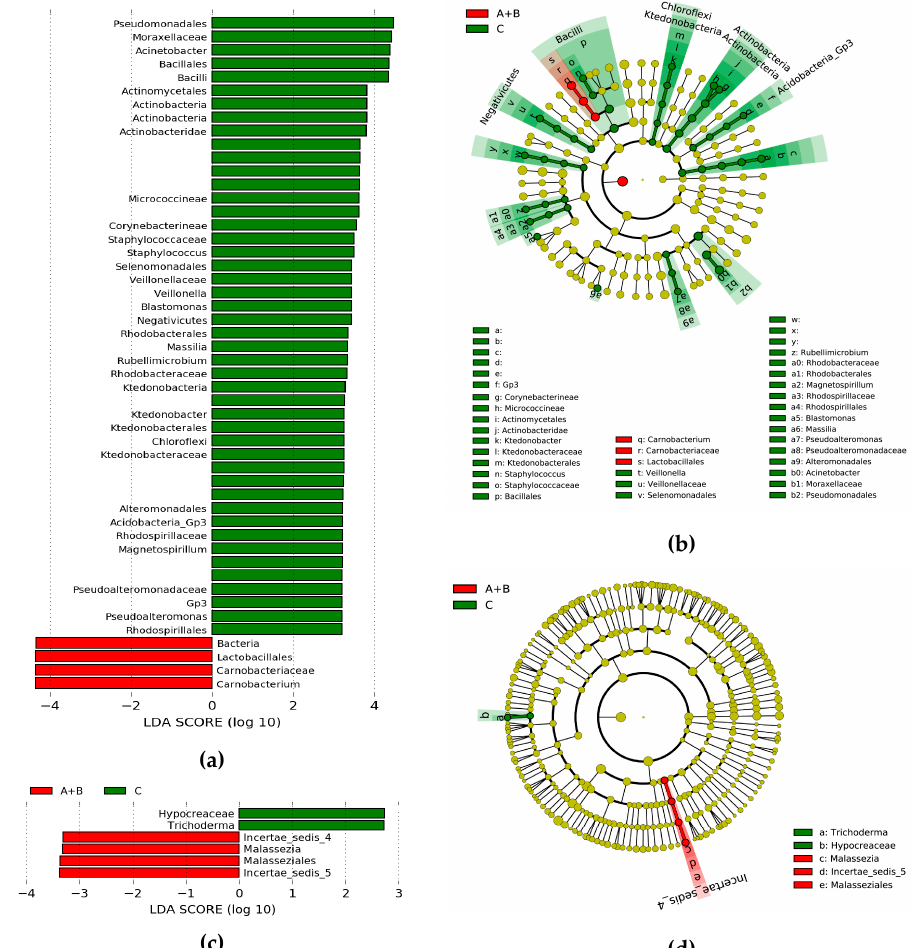
Figure 6. The microbial taxa with different abundances in Chinese cordyceps groups (sites A and B) and null Chinese cordyceps group (site C) illustrated using linear discriminant analysis (LDA) effect size analysis and cladograms. ( a ) and ( c ), the LDA scores of biomarkers of bacteria and fungi illustrated by histograms, respectively. Microbial taxa were analyzed by LDA with a significant threshold over 2.0, and the length of each bar represents the degree of differences. ( b ) and ( d ), the taxonomic information of these bacterial and fungal biomarkers was illustrated by cladograms, respectively, with circles radiating from the center point representing the taxonomic ranks from phylum to species. Red bars or nodes, taxa enriched in sites A and B; Green bars or nodes, taxa enriched in site C. Yellow nodes, taxa with no significant difference.